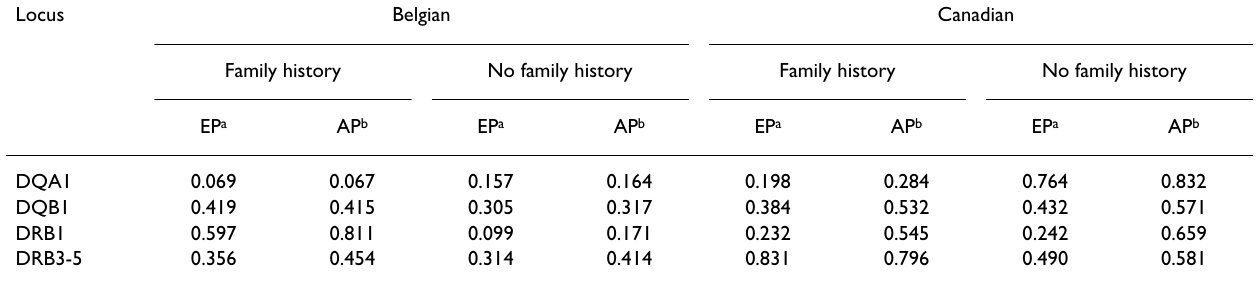
Table 6: Analysis of HLA loci in AAA cases and controls when stratified by family history of AAA Locus